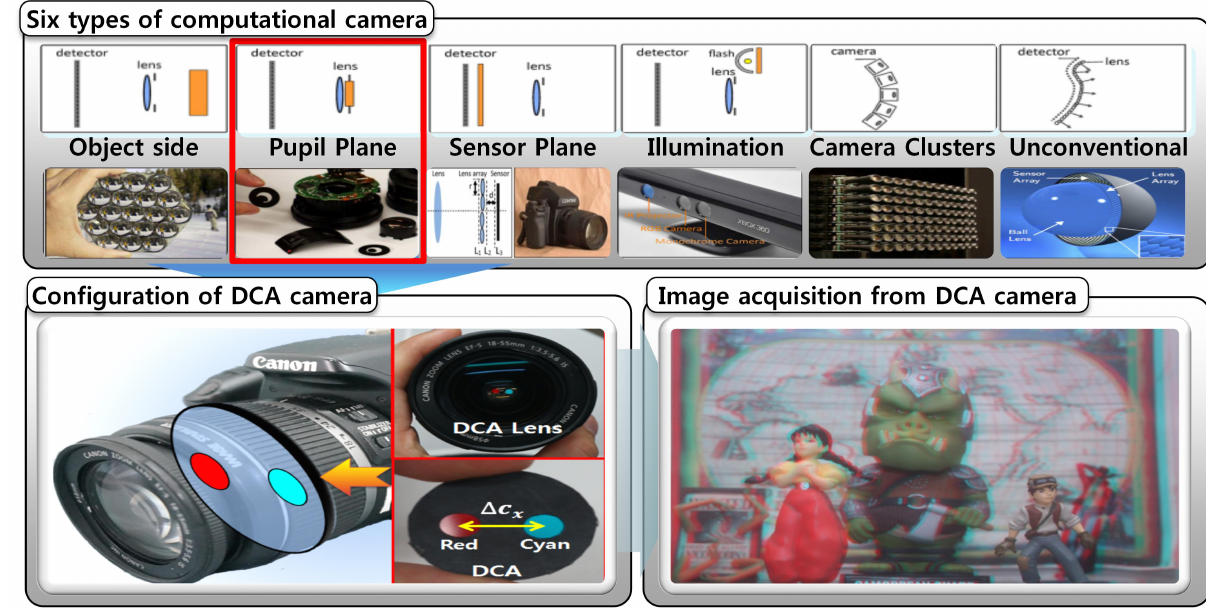
Figure 1. Six types of computational cameras and the proposed dual off-axis color-filtered aperture (DCA) camera